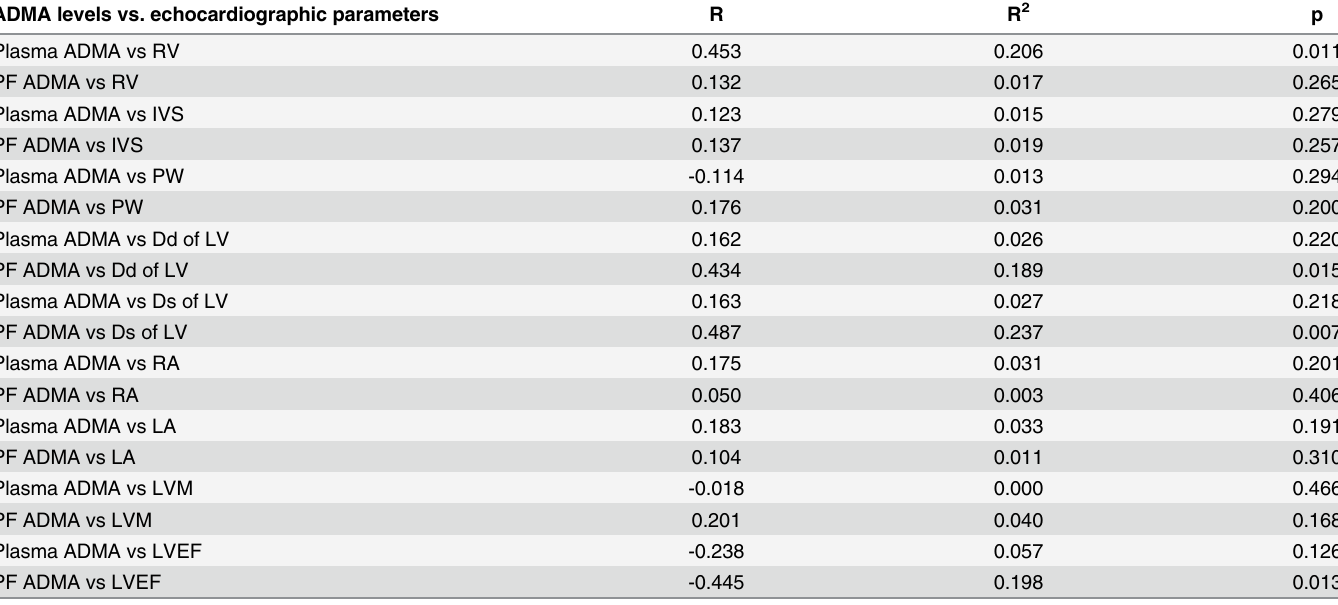
Table 3. Correlations between ADMA levels and echocardiographic parameters of patients undergoing VR surgery. ADMA levels vs. echocardiographic parameters R R